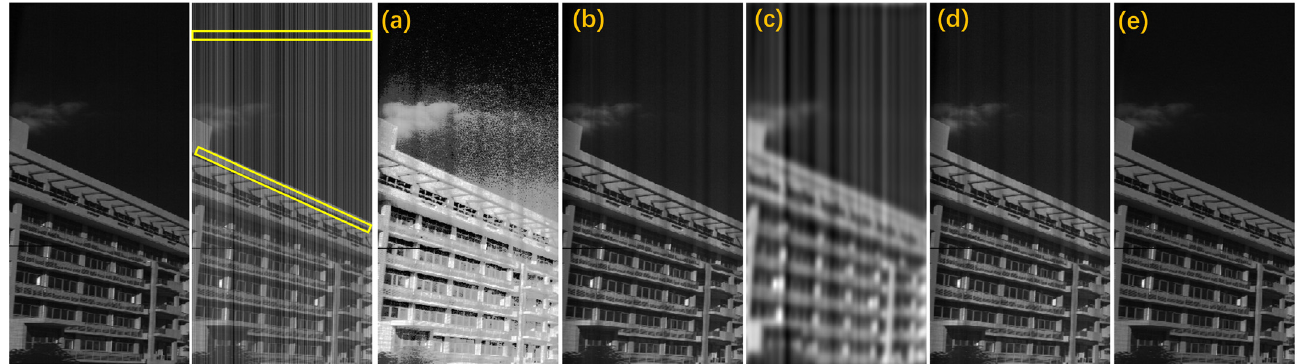
Figure 8. Calibration results of the laboratory MMS N ‐ WIR (central wavelength of 1368.2 nm) data in linear stretched images. Original N ‐ WIR image (left); image with band noise (second from the left). Correction results based on the different algorithms for the simulated images shown: ( a ) HM, ( b ) MM, ( c ) BW, ( d ) TV, and ( e ) the proposed method. Yellow squares indicate selected light and dark regions .